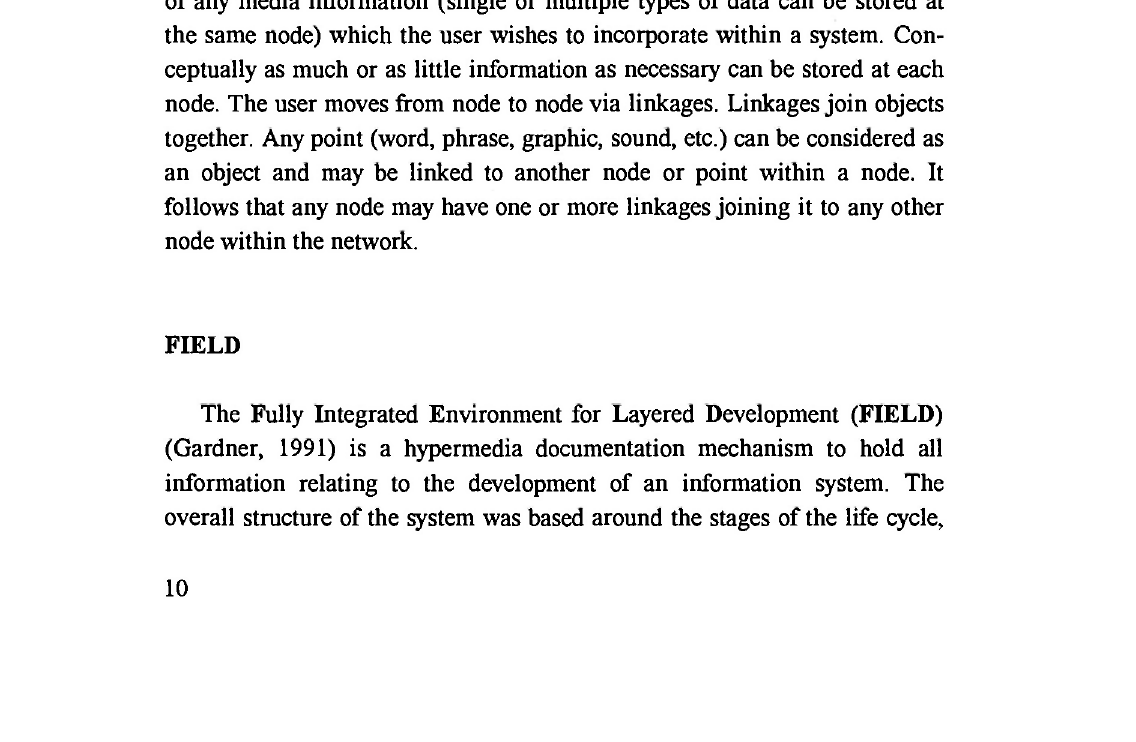
Fig. 1: The general spiral of change model of living information